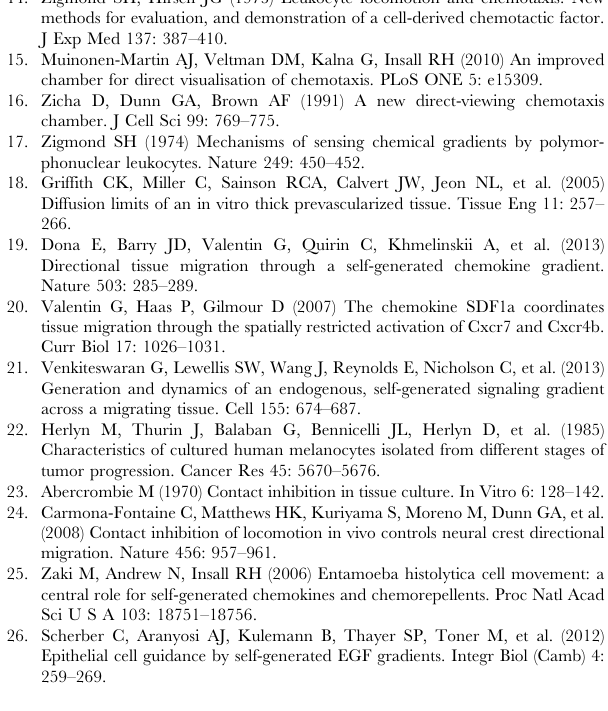
Movie S3 Outward migration up a serum gradient. WM239A cells are inoculated in the left well in medium without serum, then the right well was filled with medium containing 10% FBS. See Figure 1G for details. Time stamps and scale bar are shown for reference. (MOV) Movie S4 Effects of the LPA inhibitor Ki16425 on density-dependent dispersal. The movie shows two experi- ments, without (left) and with (right) 10 m M Ki16425. In each case both wells contains medium with 10% FBS as in Movie S1. Cells were introduced into the left lane at time zero. Time stamps and scale bar are shown for reference. (MOV) Movie S5 Effects of the LPA inhibitor Ki16425 on serum chemotaxis. The movie shows two experiments, without (left) and with (right) 10 m M Ki16425. WM239A cells were spread evenly on coverslips in chemotaxis chambers. In each case the left hand well contains medium without serum and the right hand well contains medium with 10% FBS. See Figure 4A for details. Time stamps and scale bar are shown for reference.